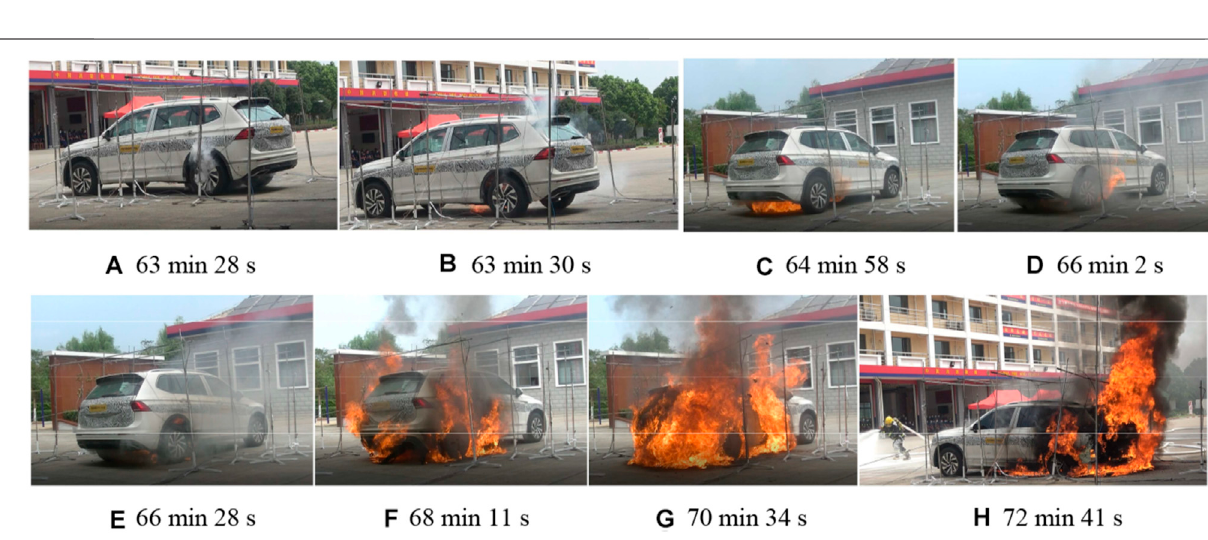
Frontiers in Energy Research |